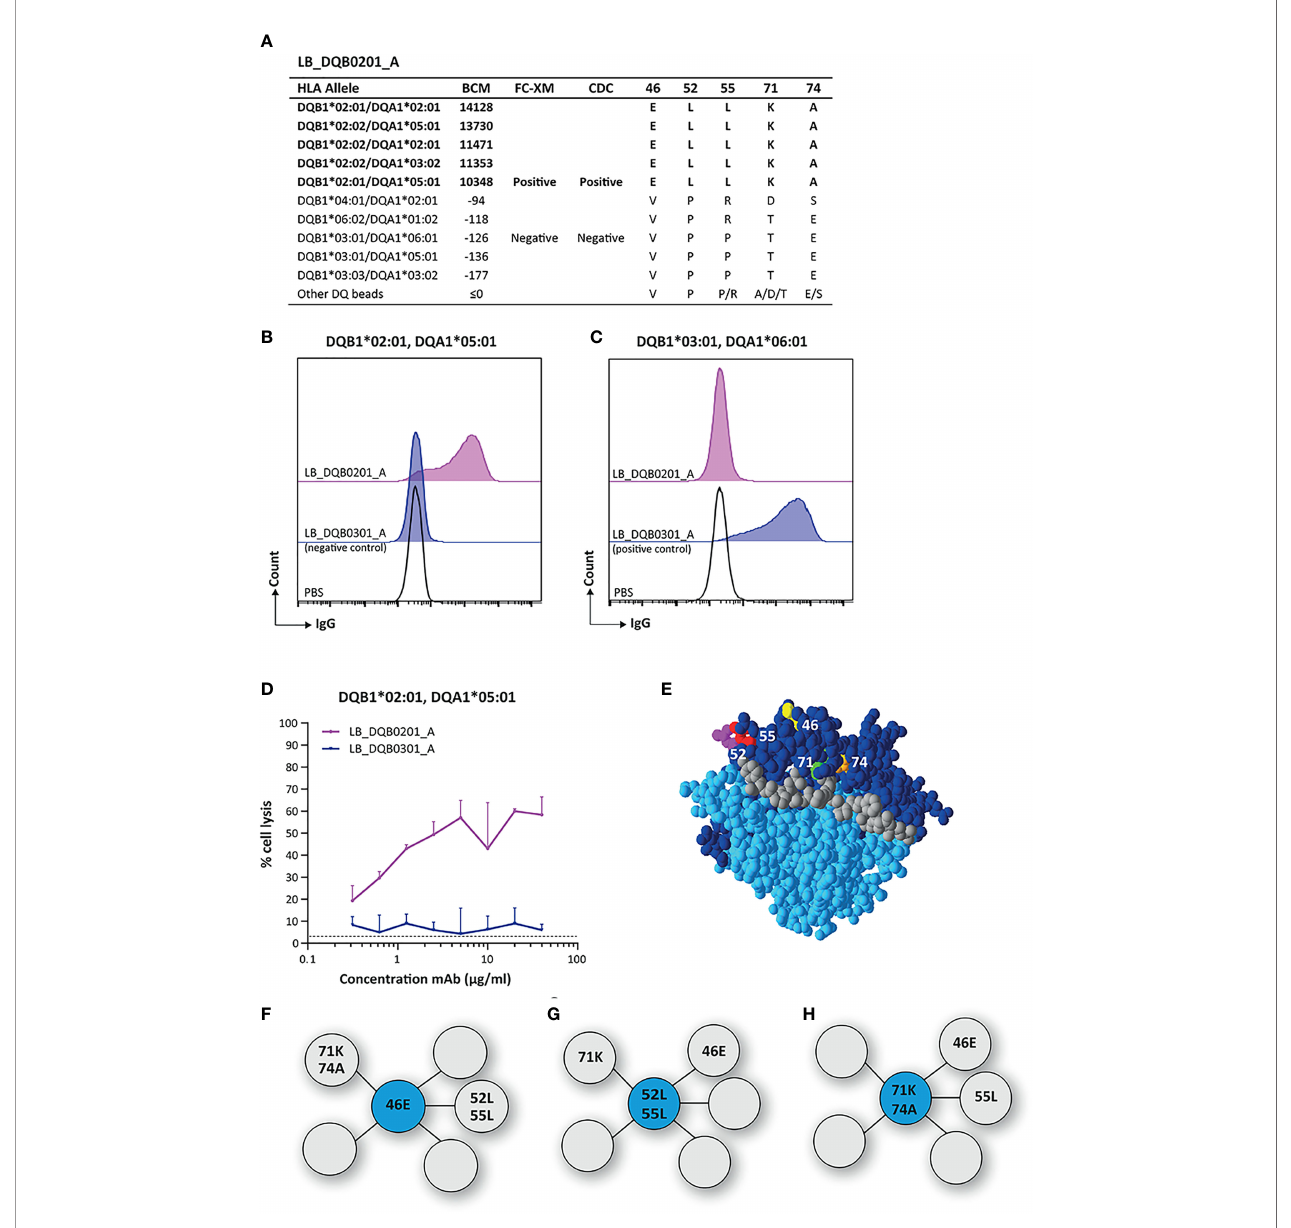
FIGURE 1 | Reactivity analysis of monoclonal antibody LB_DQB0201_A. (A) Comparison of the amino acid positions of interest of the HLA-DQB1 alleles on the reactive beads in the single antigen bead assay and a selection of the non-reactive HLA-DQB1 alleles. Flow cytometry crossmatches on EBV-LCLs expressing DQB1*02:01 (B) and DQB1*03:01 (C) showed that LB_DQB0201_A binds to natively expressed DQB1*02:01, but not to DQB1*03:01. (D) LB_DQB0201_A induced complement dependent cell lysis in a dose-dependent manner for cells expressing DQB1*02:01. (E) Locations of amino acid 46E (yellow), 52L (magenta), 55L (red), 71K (green) and 74A (orange) are indicated on the crystal structure of DQB1*02:01/DQA1*05:01 (PBD: 1S9V). The b chain is depicted in dark blue, the a chain in light blue, and the peptide in grey. (F) Schematic representation of the antibody-footprint of LB_DQB0201_A with 46E or (G) 52L+55L or (H) 71K+74A as the functional epitope (cyan) with additional AA con fi gurations (grey). Monoclonal antibody concentrations used for testing were 20 µg/ml for single antigen bead assay and FC-XM and 0.3125 - 0.625 - 1.25 - 2.5 - 5 - 10 - 20 - 40 µg/ml for CDC. BCM, background corrected mean fl uorescence intensity; FC-XM, fl owcytometric crossmatch; CDC, complement dependent cytotoxicity; PBS, phosphate-buffered saline; mAb, monoclonal antibody; EBV-LCL, Epstein-Barr Virus-transformed lymphoblastoid B-cell line; PBD, Protein Data